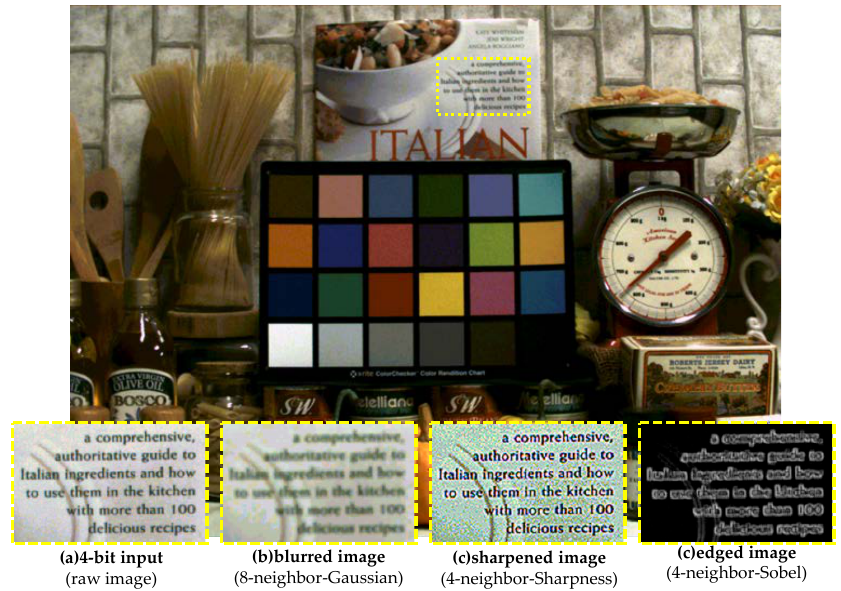
Figure 14. Results of spatial filtering. This is the result of a filter in the yellow area. ( a ) Raw data; ( b ) eight-neighbor Gaussian; ( c ) four-neighbor sharpness; ( d ) four-neighbor Sobel.